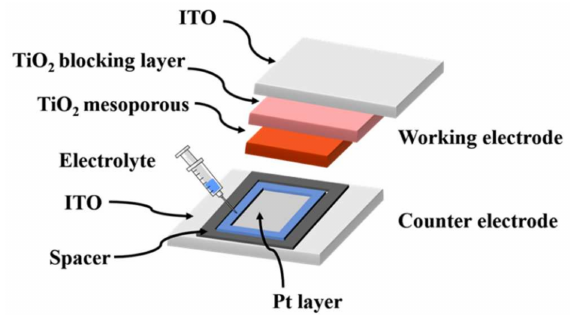
Figure 1. Schematic diagram of the assembled